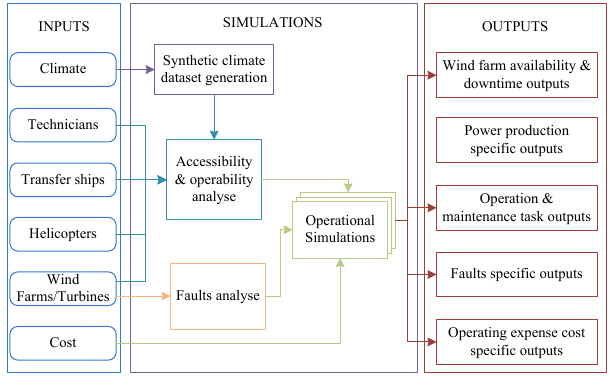
Figure 22. Operation and maintenance